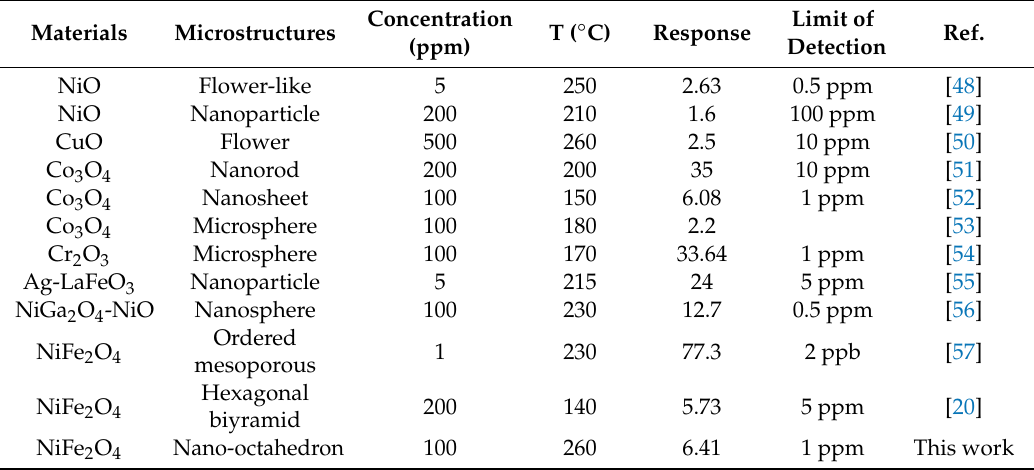
Table 1. Comparison of toluene sensing performance among the gas sensors based on typical p-type